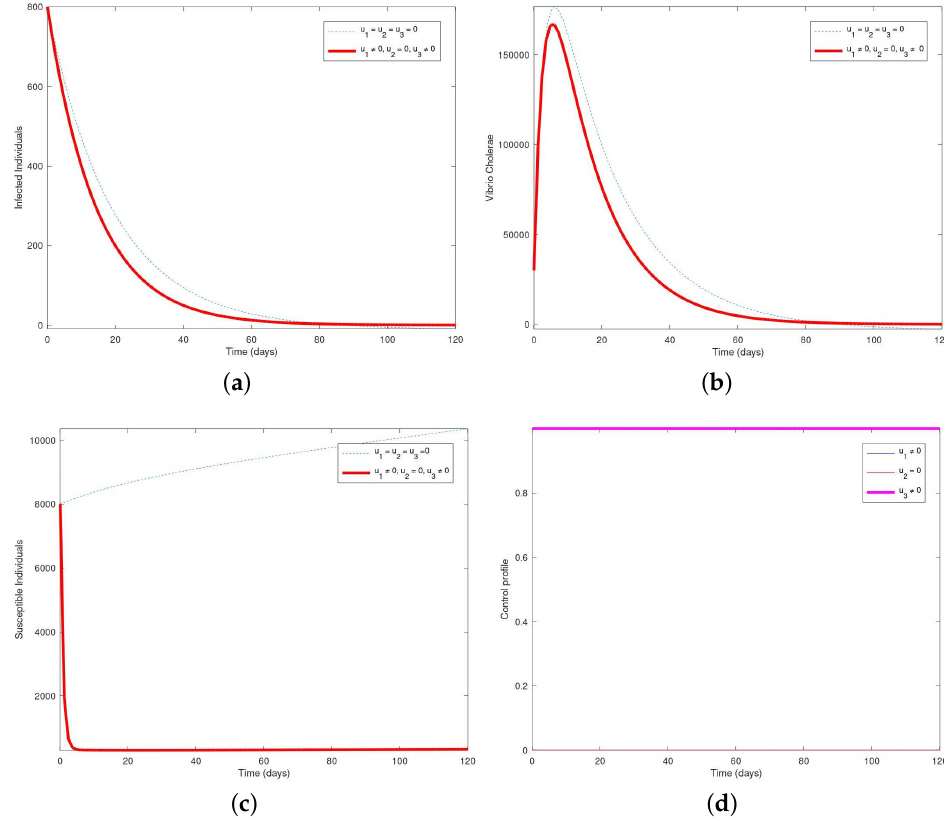
Figure 5. Simulation showing the population of ( a ) infected, ( b ) vibrio cholerae, ( c ) susceptible and ( d ) the control profile with ( u 1 , u 3 ) . In Figure 5a, the population of infected humans decreases essentially after 80 days until the disease was wiped out completely. Figure 5b reveals that the number of vibrio cholerae increases slightly and then decreases completely after 80 days and then vanishes completely. In Figure 5c, the number of susceptible humans completely decreases within 2 days and then vanishes from the system in the presence of the control interventions within 2–120 days. In Figure 5d, the control profile showed that the control ( u 1 ), and ( u 3 ) remained constant from day 1 till the end of the 120 days while ( u 2 ) maintained lower